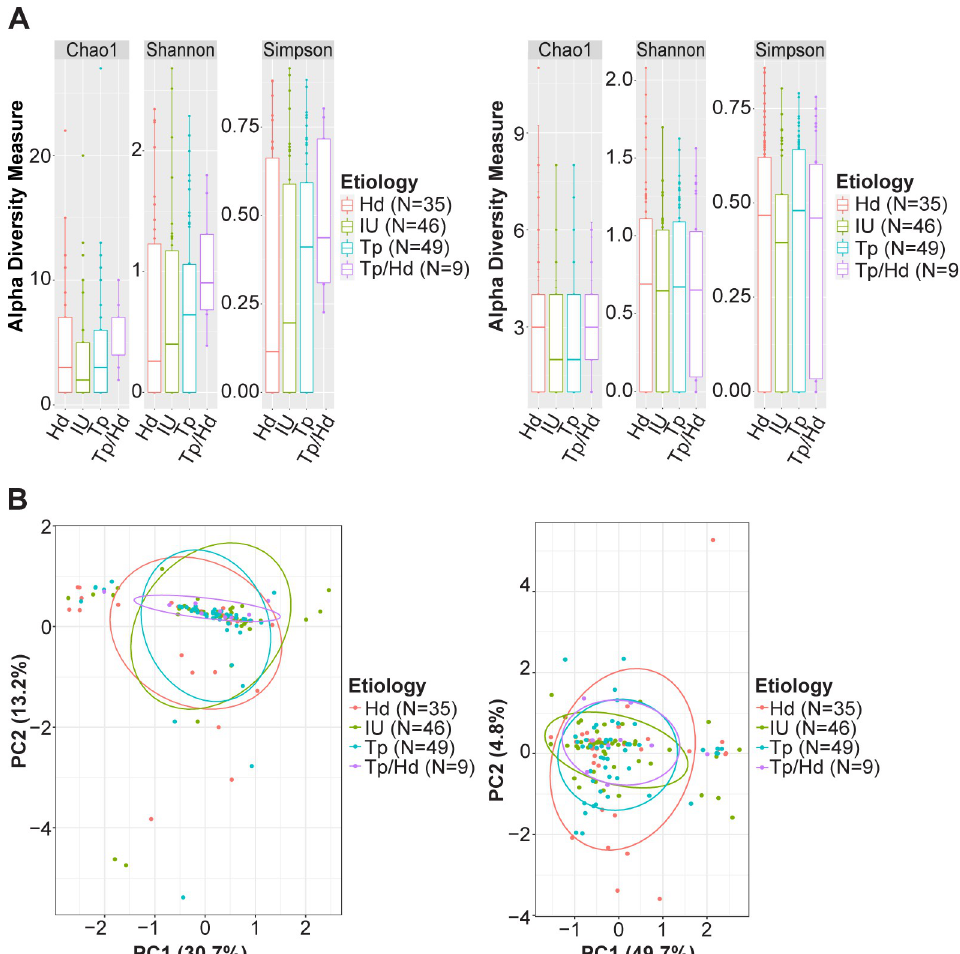
Fig 2. Alpha and beta diversity estimates in the stringent dataset. (A) Box plots showing Chao1 richness estimate and Shannon and Simpson diversity indices for bacterial (left) and viral (right) taxa from ulcers. No significant differences were observed (P > 0.05). (B) Principal component analyses of bacterial (left) and viral (right) taxa from ulcers. Data was first transformed using additive log ratio with human reads as the invariant taxon. All PERMANOVA comparisons of groups using only bacterial taxa were significantly different (P < 0.05), while no comparisons of groups using only viral taxa were significant (P > 0.05).